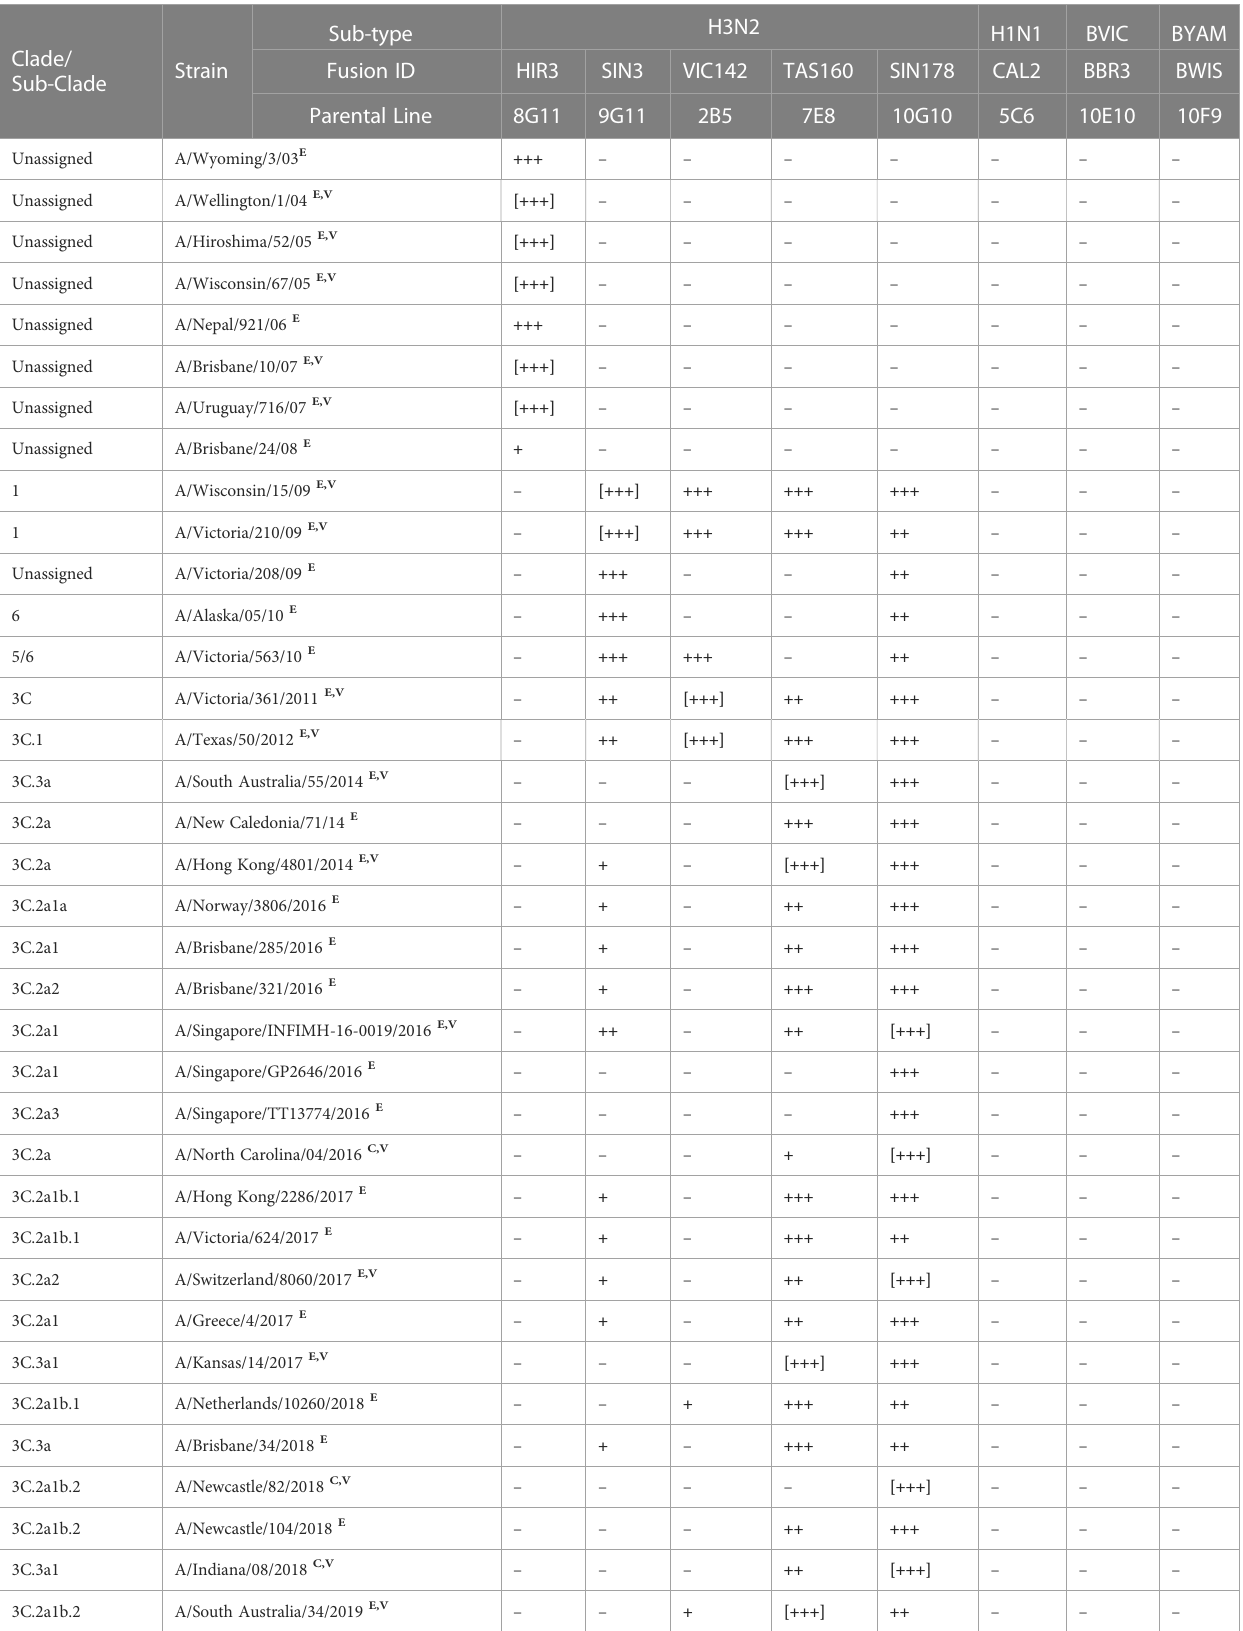
TABLE 1 Cross reactivity of monoclonal antibody (mAb) panel speci fi c to sub-type H3N2 screened against egg derived (E) and cell derived (C) vaccine antigen.